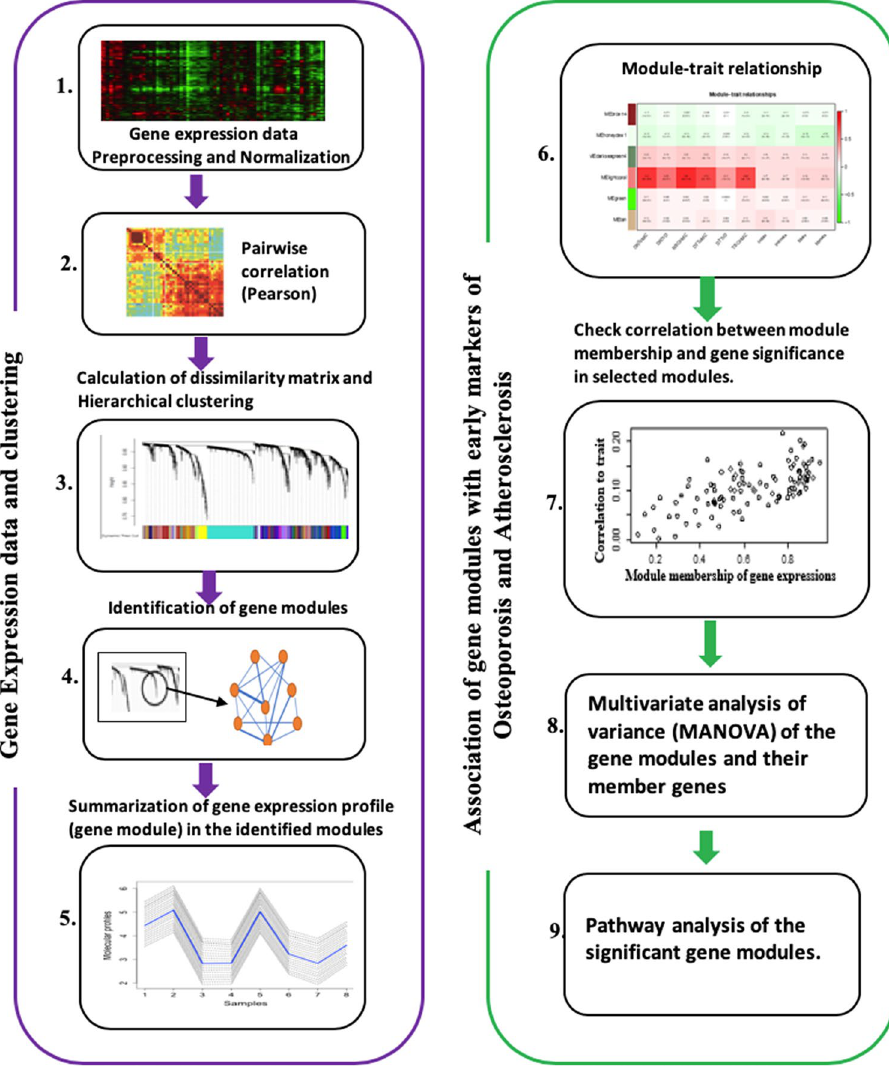
Figure 1. Weighted gene co-expression network analysis pipeline (Figure adapted from Fig. 1 in 7 ). 1) Gene expression data analysed using Illumina HumanHT-12 version 4 Expression BeadChip. 2) Correlation matrix based on the pairwise correlations (Pearson) of the gene expression data. 3) Hierarchical clustering of the dissimilarity matrix generated from the correlation matrix. 4) Identification of gene modules based on clustering. 5) Summarization of the gene expression profile in the modules by calculating their first principal component. 6) Correlation between the modules’ summary expression profiles (representative of modules) and a set of early traits of osteoporosis and atherosclerosis. 7) Examination of the correlation between module membership and the gene significance of the gene module in the selected modules as a quality check for the modules. 8) Multivariate analysis of variance (MANOVA) of the gene modules and their member genes. 9) Pathway analysis of the member genes of the significant gene